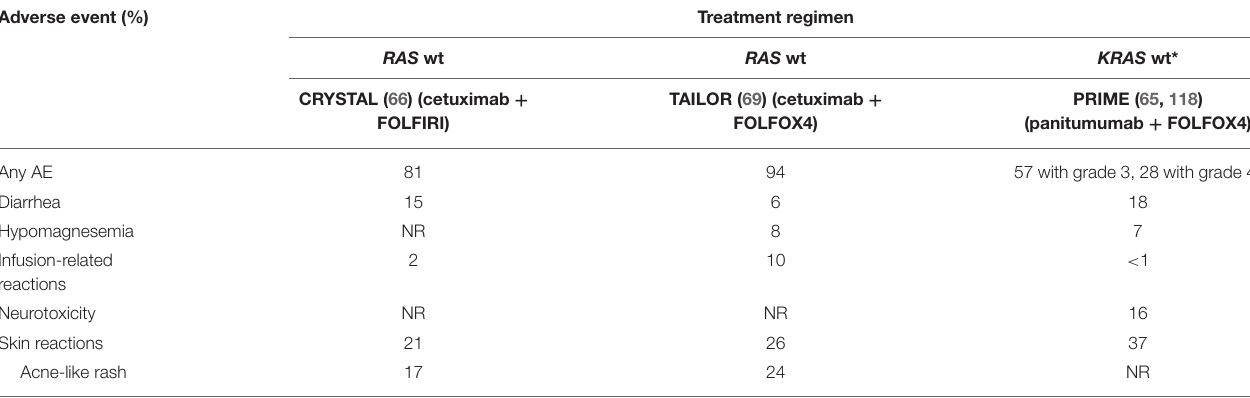
TABLE 4A | Comparison of cetuximab- and panitumumab-associated grade 3/4 adverse events: evidence from (A) first-line and (B) third-line phase 3 trials. Adverse event (%) Treatment regimen